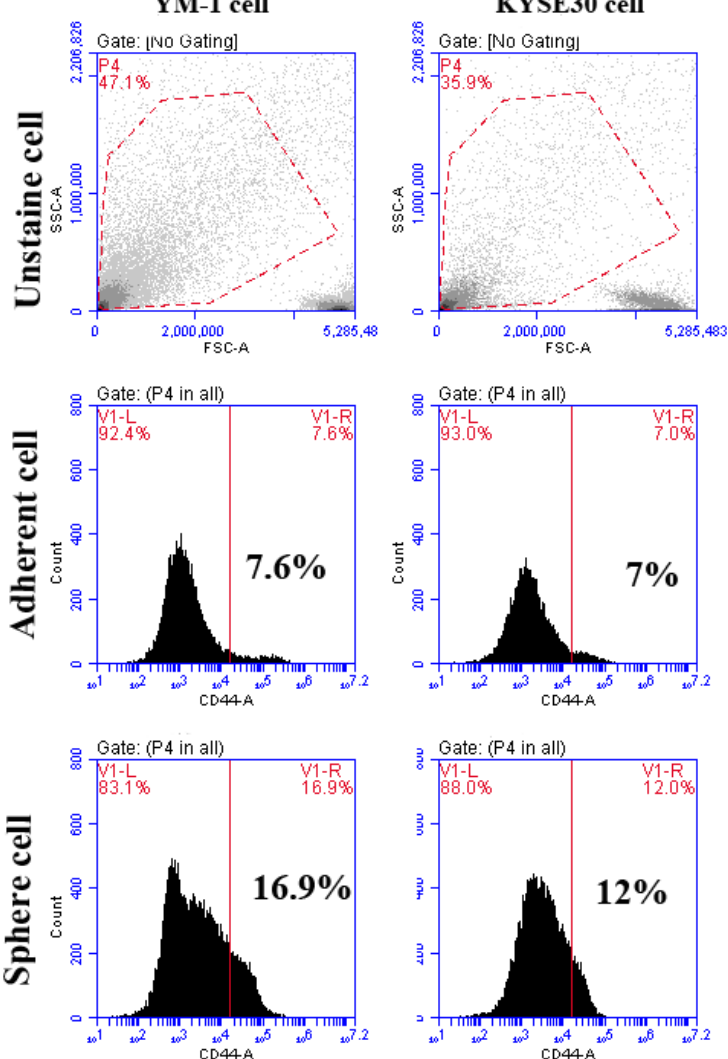
Figure 2. The flowcytometry analysis of CD44 cancer stem cell marker in adherent and tumorspheres. The percentages of CD44 positive cells are shown in the graphs. The unstained cell was used for background subtraction.